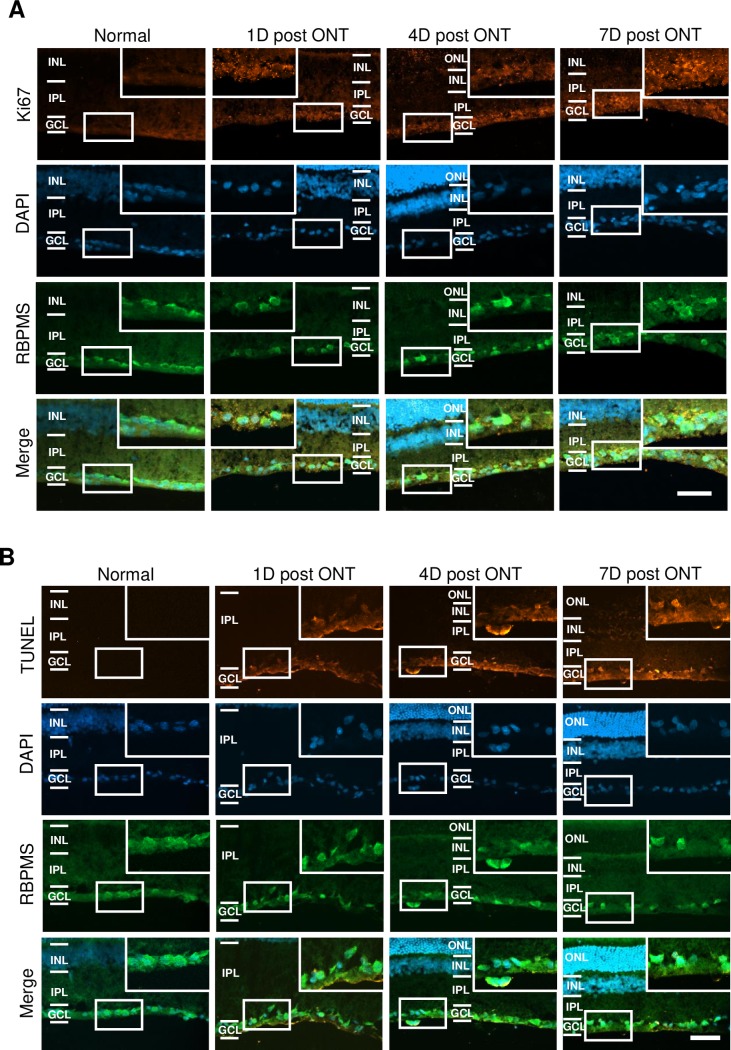
ONT induces Ki67 expression and DNA damage in RGCs.(A) Immunofluorescent micrographs of transverse sections of the retina showing diffuse Ki67 expression in the GCL after ONT, at 1, 4, or 7 days postaxotomy. Scale bar = 50 μm. (B) Immunofluorescent micrographs of transverse sections of the retina showing TUNEL expression in the RGCs after ONT, at 1, 4, or 7 days postaxotomy. Scale bar = 50 μm.